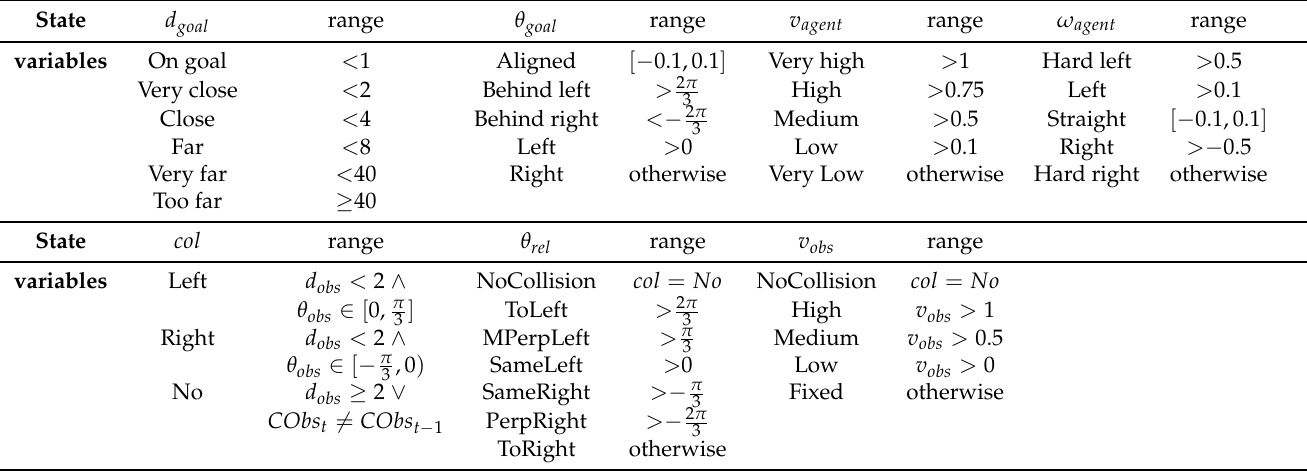
Table 1. Discrete states for RL.